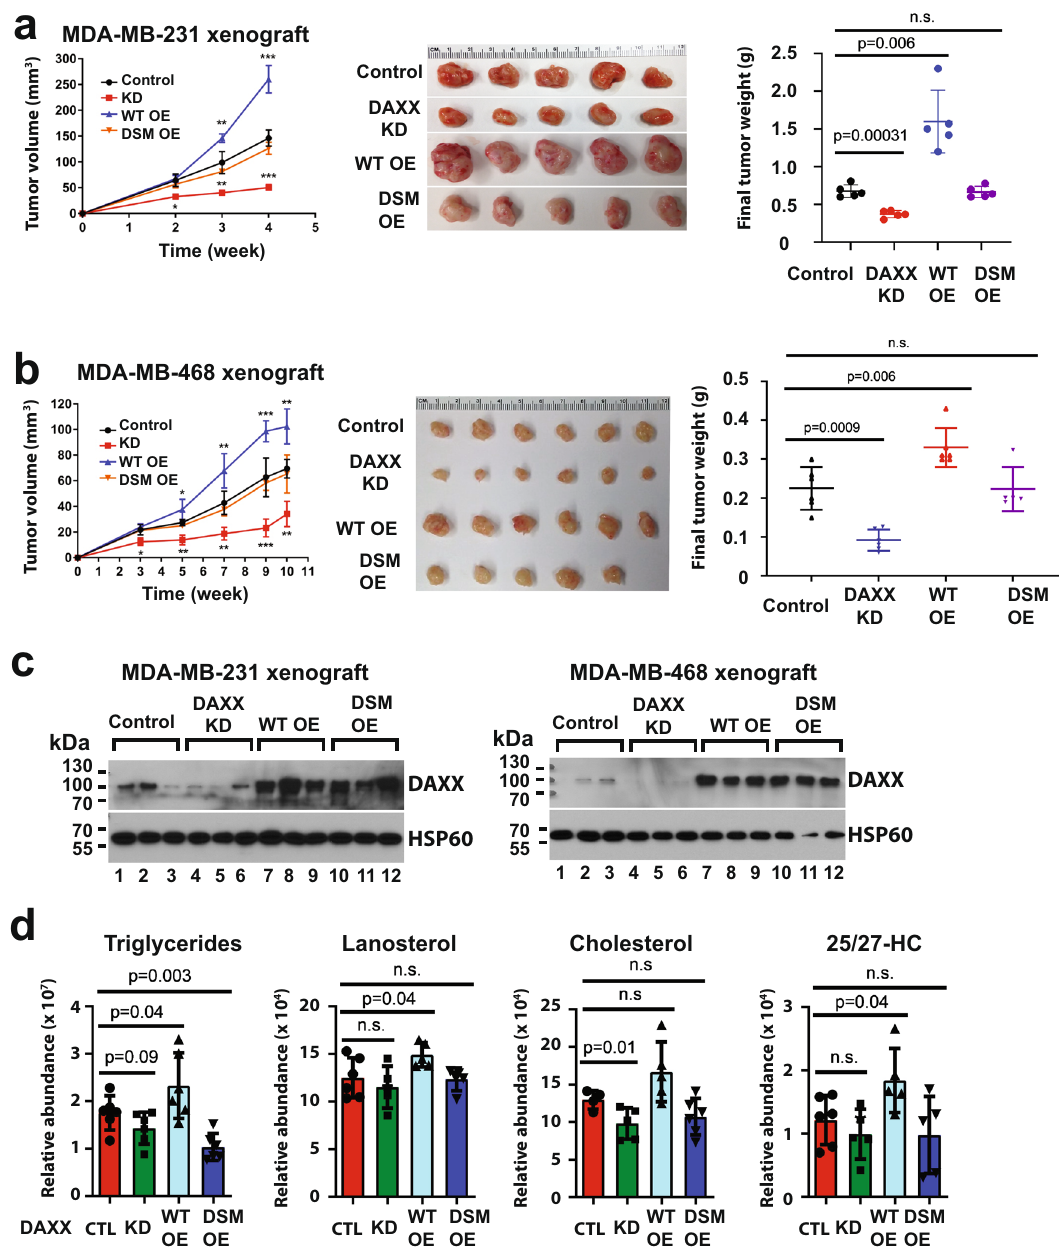
Fig.5|WTDAXXbutnottheSUMO-bindingdefectivemutant(DSM)promotes tumor growth in vivo. a , b Cell lines derived from MDA-MB-231 or MDA-MB-468 stably transduced with a control vector (Control), DAXX shRNA (KD), wild-type DAXX cDNA (WT OE), or the mutant defective of SUMO-binding ( DSM OE) were implanted into mammary fat pads of female NSG mice. Longitudinal tumor volumes are plotted. Tumor images and weights at the endpoint are shown ( n =5 for MDA-MB-231, and n =5 or 6 for MDA-MB-468 xenograft tumors, respectively). c DAXXoverexpressionwasmaintainedforboththeWTandDSMmutantproteins.